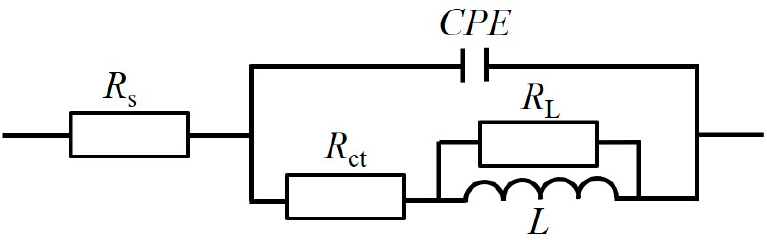
Figure 3. Equivalent circuit model used to fit EIS experiment data of carbon steel electrode.